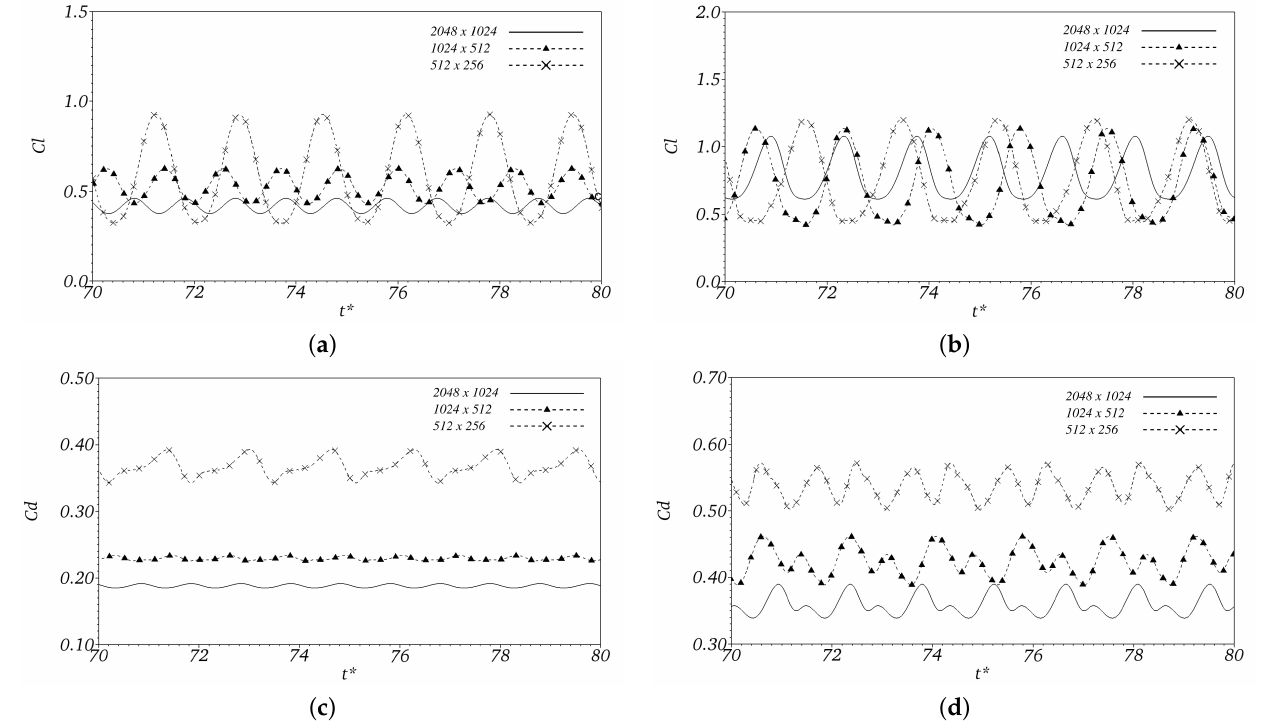
Figure 7. Influence of mesh refinement on C l × t ∗ : ( a ) 10 ◦ and ( b ) 16 ◦ . Influence of mesh refinement on C d × t ∗ : ( c ) 10 ◦ and ( d ) 16 ◦ .